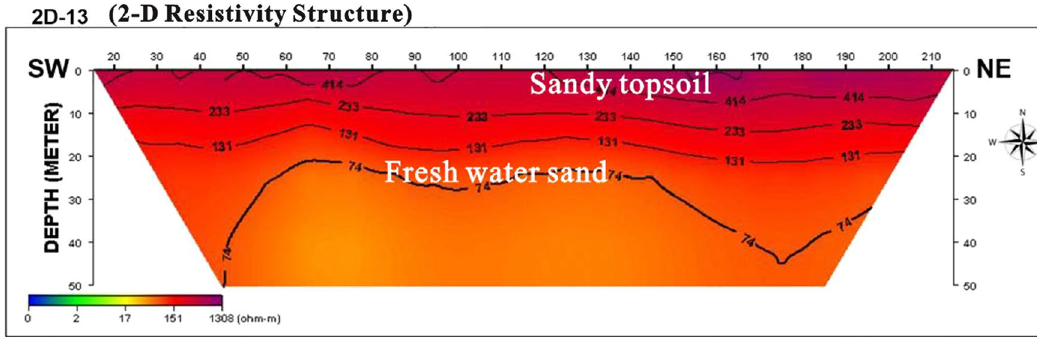
Fig. 17 Resistivity imaging of Traverse 2D-13